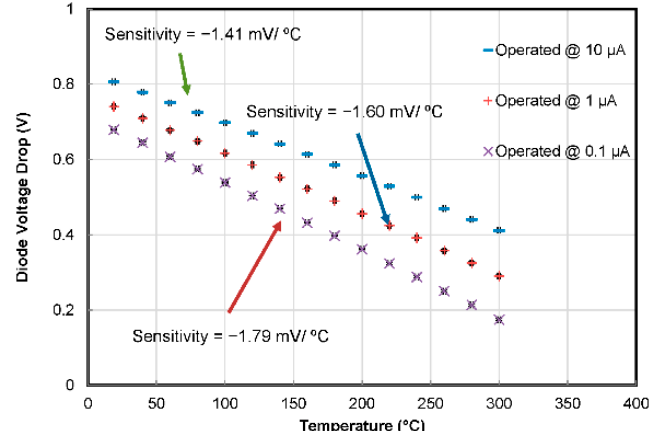
Figure 11. Calibration curve of two different thermodiodes from two different SOI CMOS MEMS chips operated at three different current levels with standard deviation error bars. The temperature sensors have shown an excellent repeatability of the results.